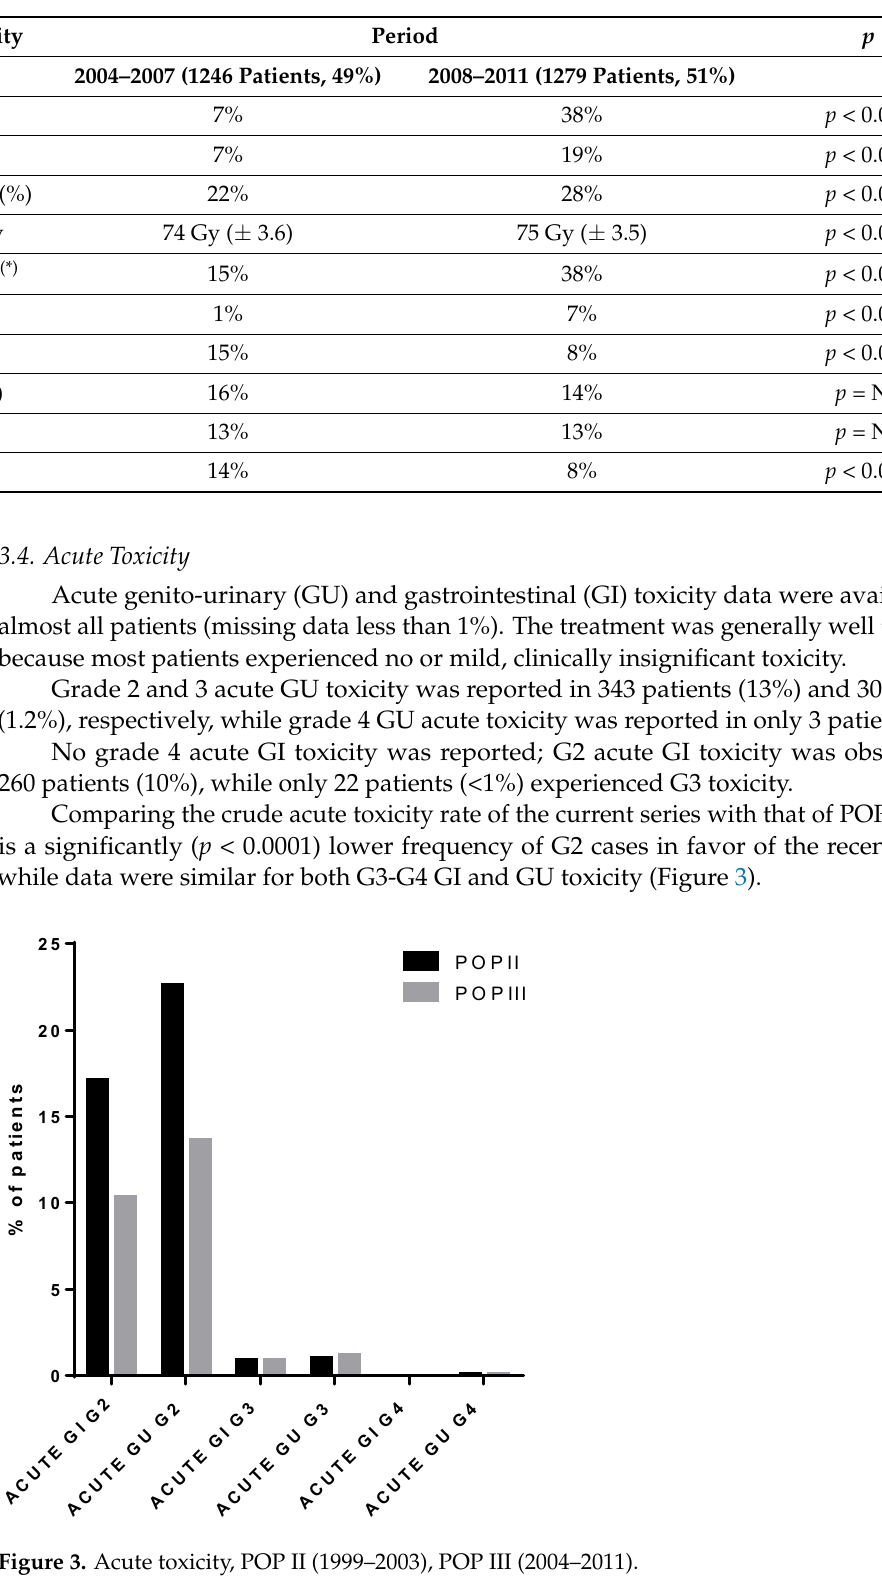
Table 4. Techniques, doses, CTV-PTV margins and toxicity in the first and second half of the accrual period; (*) = data unknown for 153 cases. Pts =